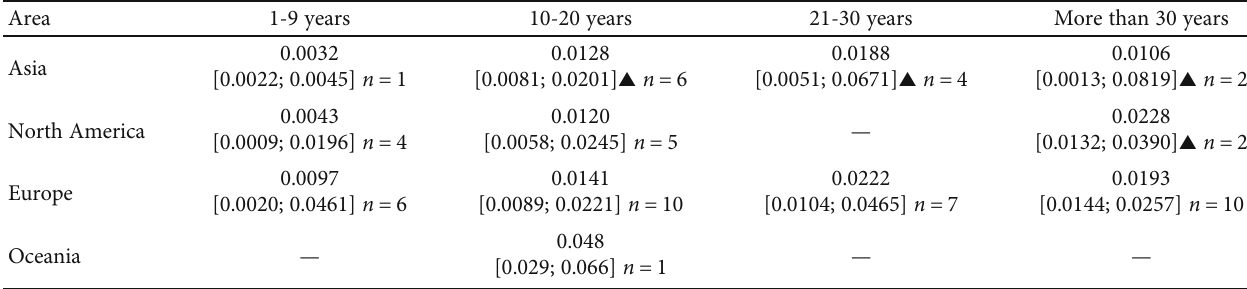
Table 6: Geographic variation in UC patients in di ff erent disease durations.